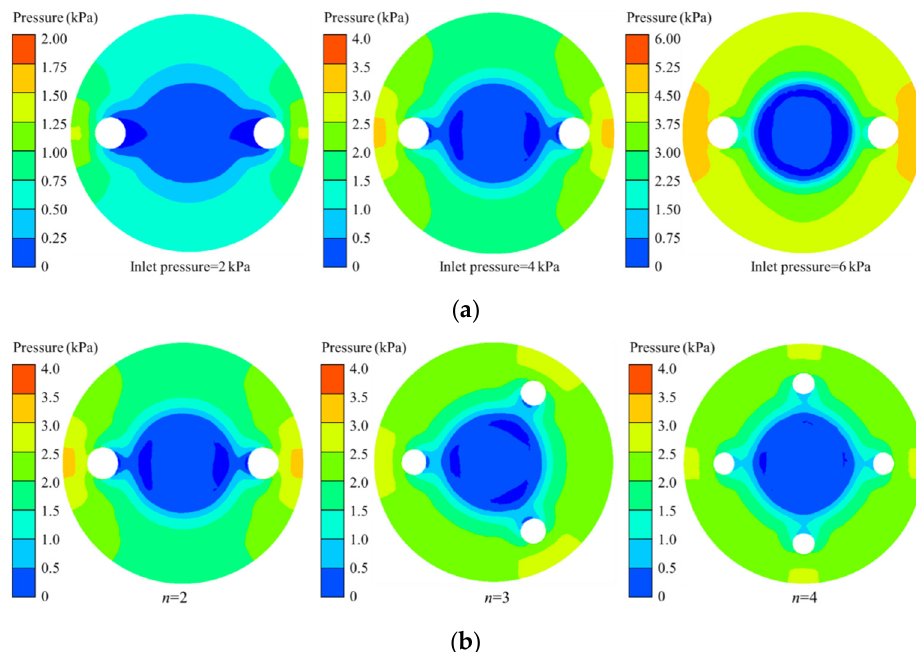
Figure 9. Pressure distribution for lower surface of the membrane in microvalve. ( a ) Different inlet pressure with n = 2, ( b ) different number of microholes with inlet pressure of 4 kPa.